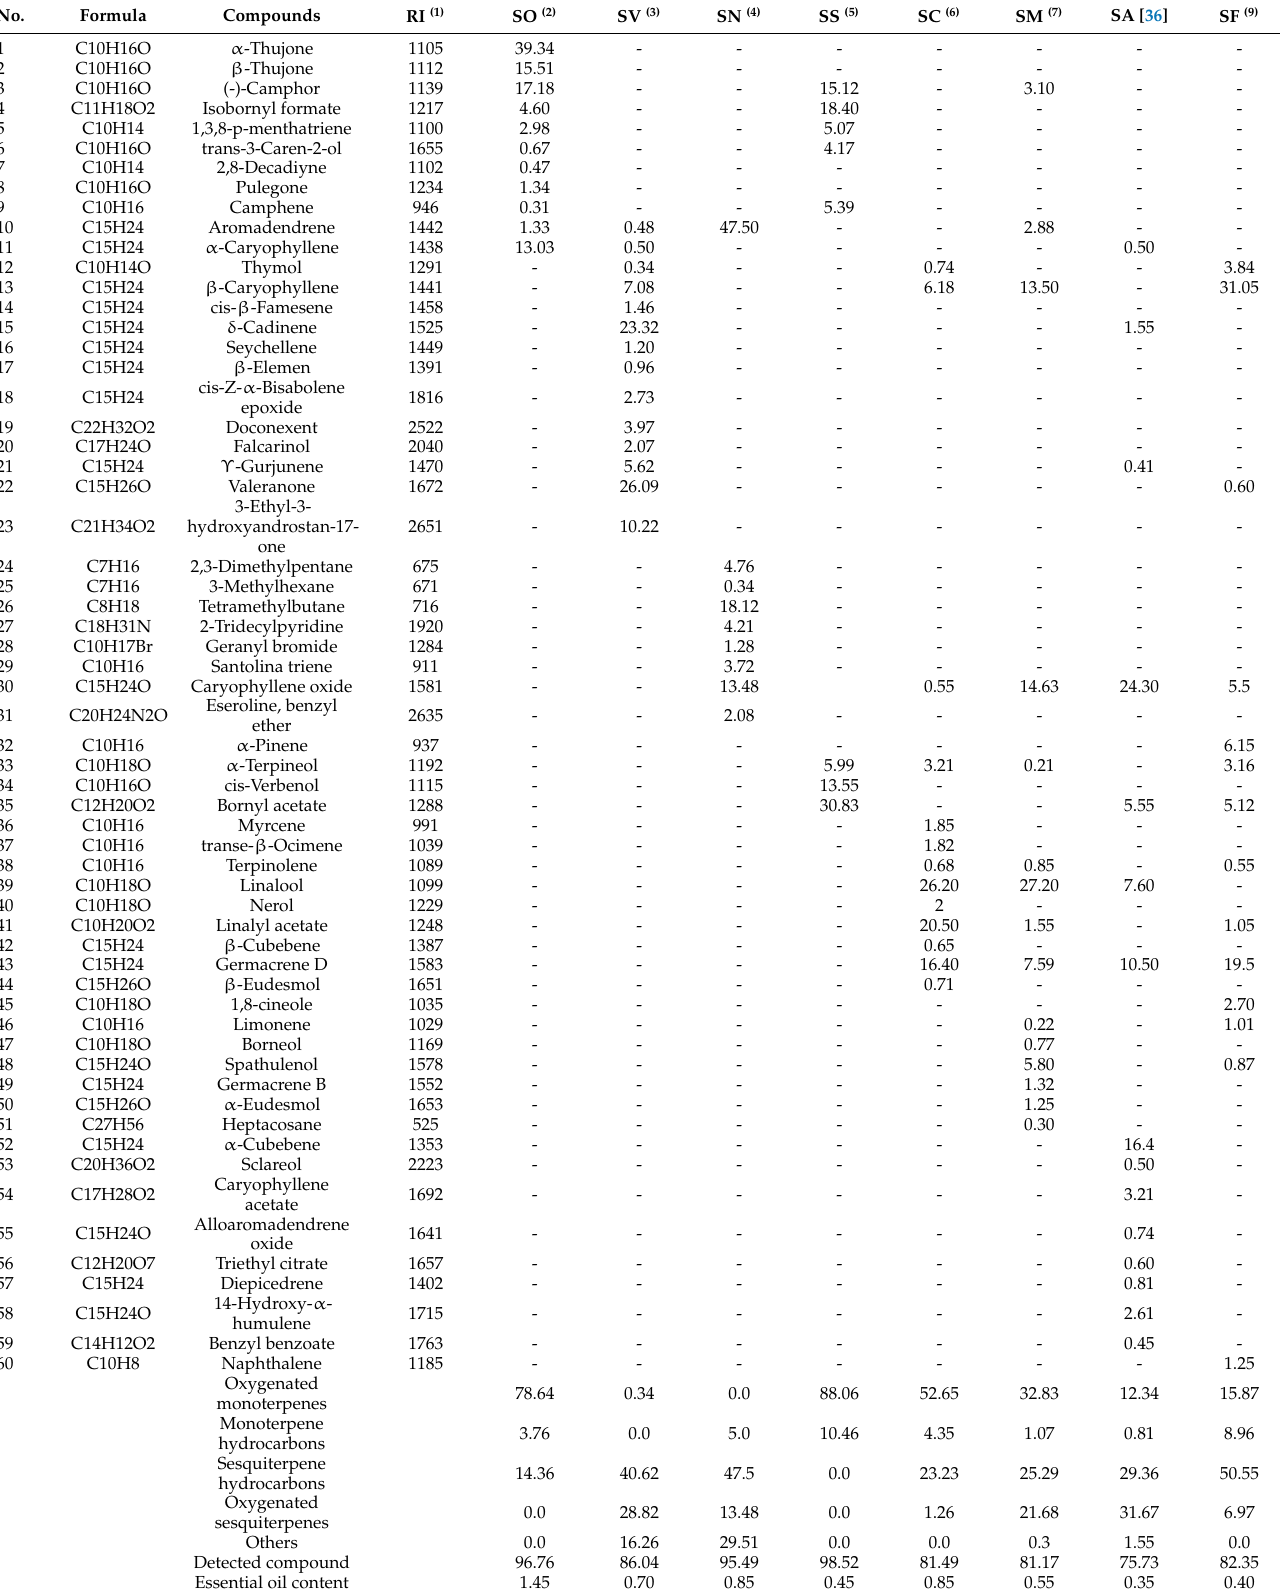
Table 3. Essential oil composition (% of principal components) of some Salvia species cultivated in Khorasan Razavi province,